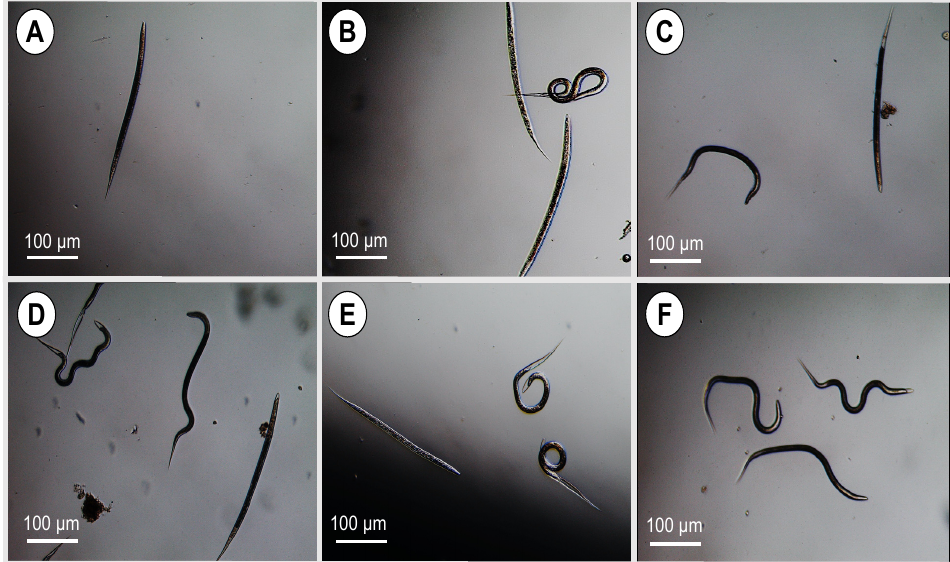
Figure 13. Microscopical examination of third stage larvae (L3s) of H. contortus after exposure to CS-PLGA particles loaded with combined EO components at ( A ) 10 μ g/mL, ( B ) 5 μ g/mL, ( C ) 2.5 μ g/mL, and ( D ) 1.25 μ g/mL. ( E ) L3s treated with 20 mg/mL levamisole were used as a positive control. ( F ) Untreated L3s were used as a negative control. Dead L3s in the treated and positive control samples were immobile upon prodding. Negative control larvae were actively motile even after several days of incubation. Scale bar = 100 μ m.